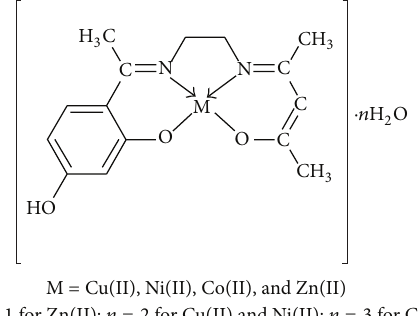
Figure 2: Proposed structure of metal